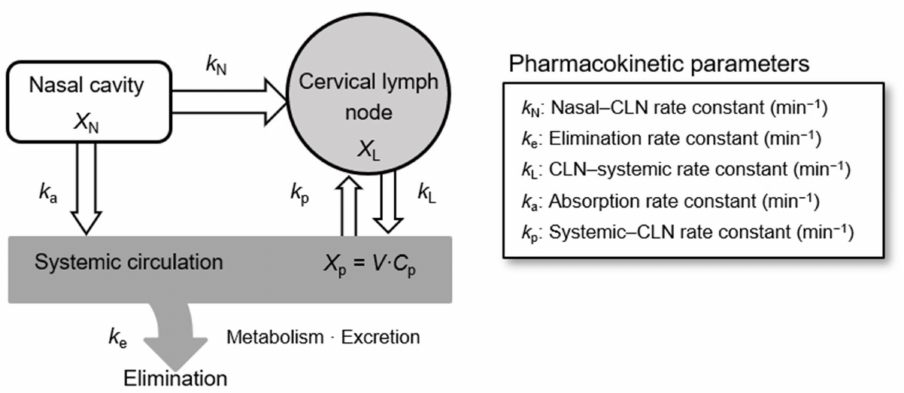
Figure 1. Model illustrating drug absorption and disposition following nasal administration and associated pharmacokinetic parameters. Abbreviations: CLN, cervical lymph node; X , mass of methotrexate in each compartment; k , rate constant; V , volume of distribution; C , concentration of methotrexate; N, nasal cavity; L, cervical lymph node; p,